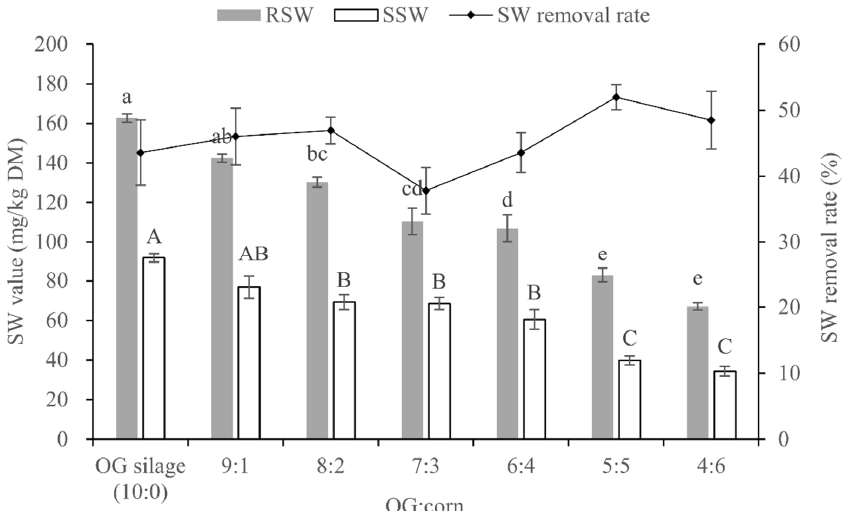
Figure 2. Swainsonine (SW) content prior to and after ensiling of Oxytropis glabra (OG) mixed with whole-plant corn at different ratios, and the rate of SW removal from the silages. Means without a common superscript letter differ ( p < 0.05); error bars denote the standard error of three replicates. RSW, SW content of raw materials; SSW, SW content of silages. Polynomial contrasts: RSW, p < 0.001 (linear), p = 0.893 (quadratic), p = 0.251 (cubic); SSW, p < 0.001 (linear), p = 0.361 (quadratic), p = 0.222 (cubic).